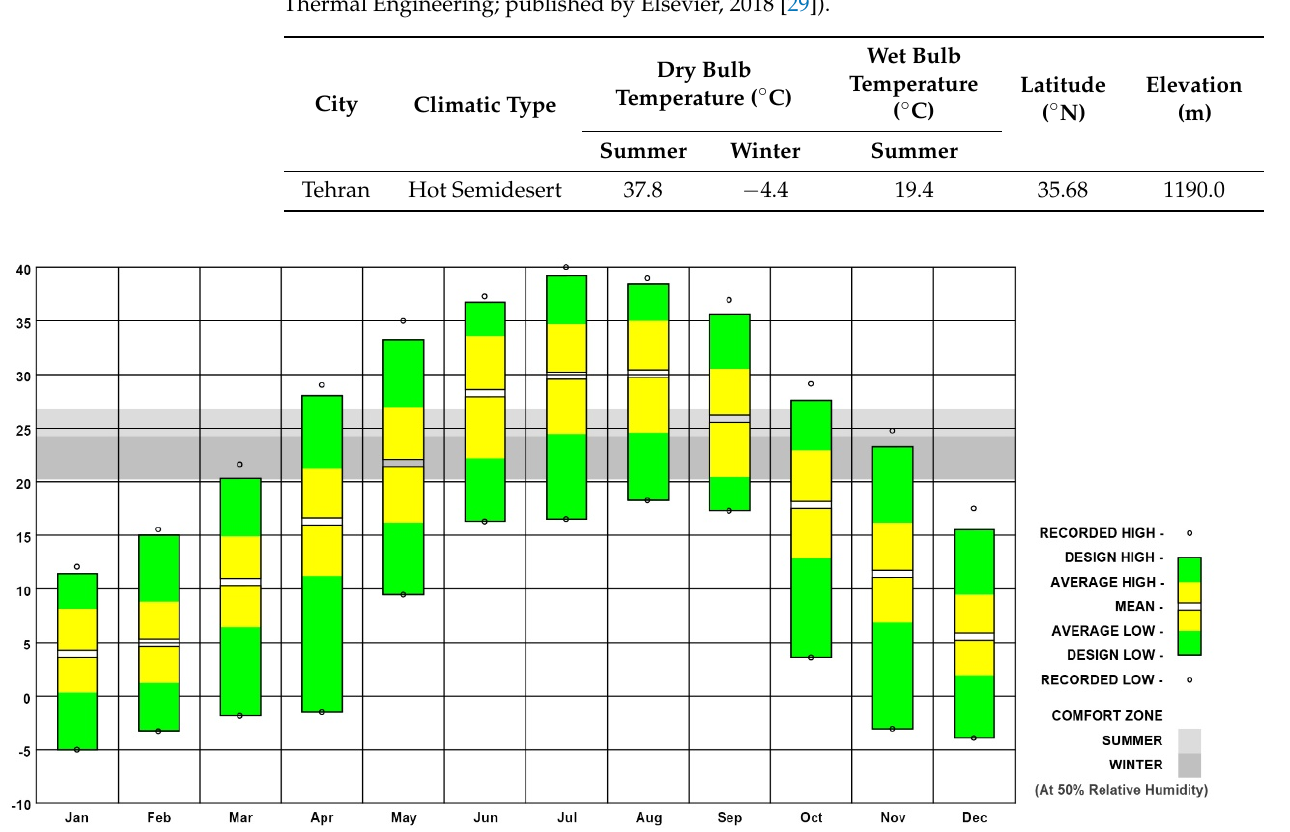
Figure 3. Temperature range in different months of a year for Tehran.